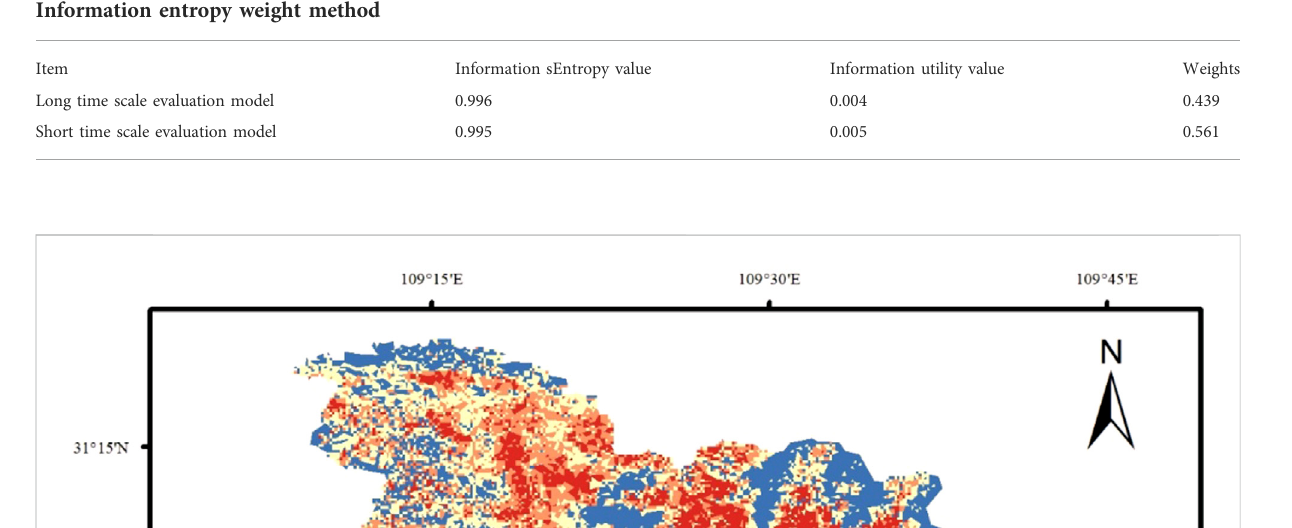
TABLE 3 Results of the information entropy weight method.